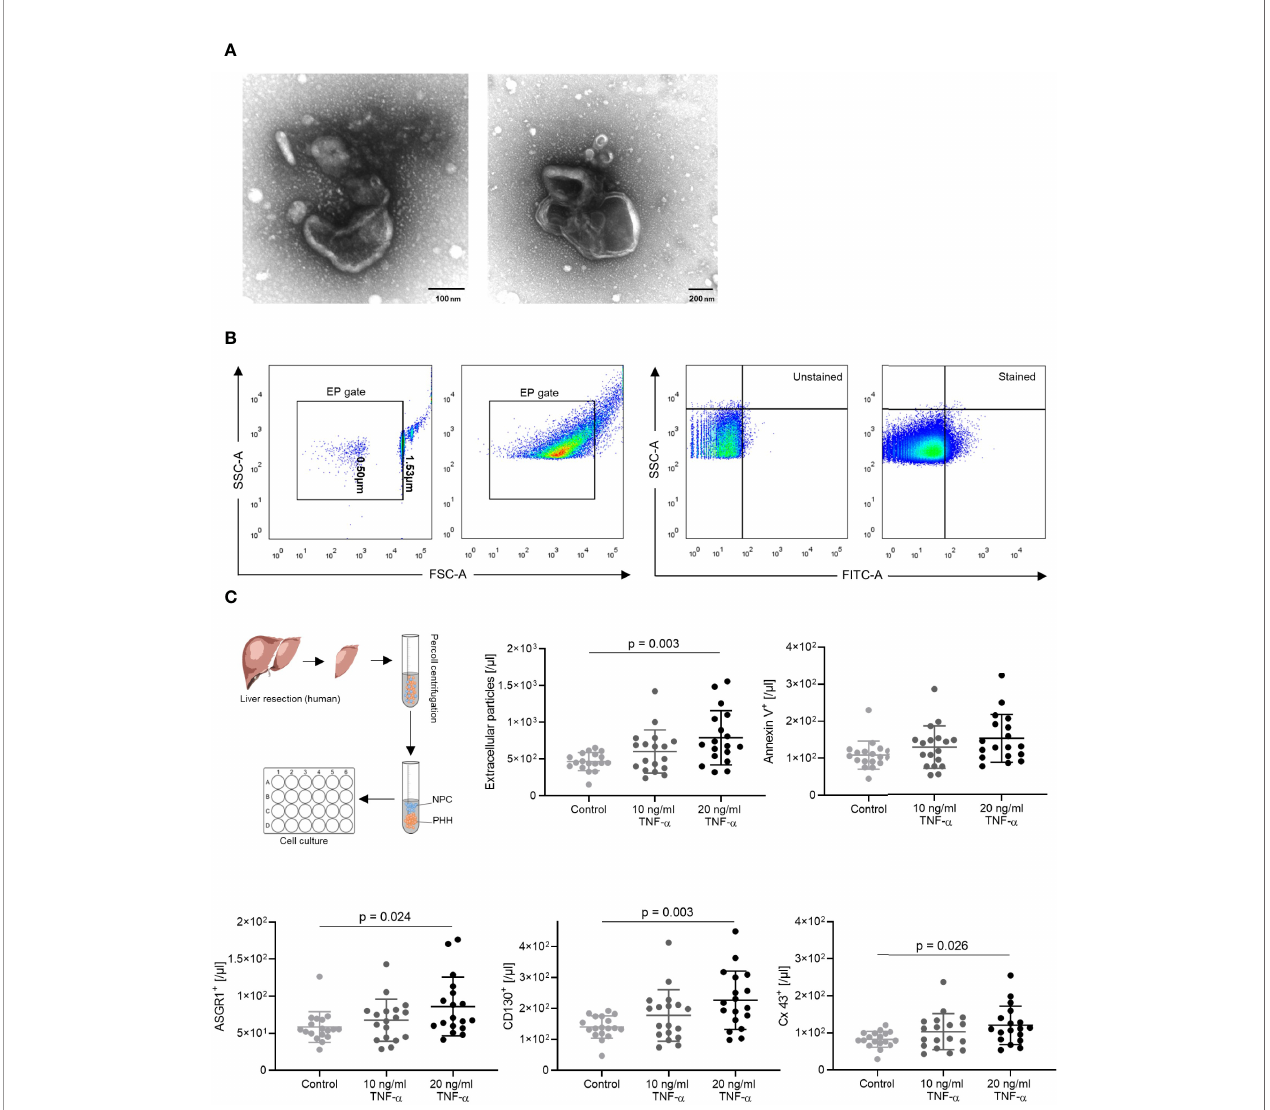
FIGURE 1 | EP gating strategy and in vitro results. (A) Transmission electron microscopy images of EP. (B) The EP gate was de fi ned using 0.5 µm and 1.53 µm calibration beads. EP population shift was observed after staining with ASGR1 antibodies. (C) In vitro , TNF- a induced human hepatocyte – derived EP. Primary human hepatocytes following liver resection were isolated, cultured overnight, and stimulated with 10 and 20 ng/ml TNF- a . EP surface antigens were stained, and absolute AnnV + , CD130 + , Cx43 + , ASGR1 + EP were analyzed. The ordinary one-way ANOVA with Tukey ’ s post hoc test was used. The plots are indicated by the mean, and all error bars indicate the